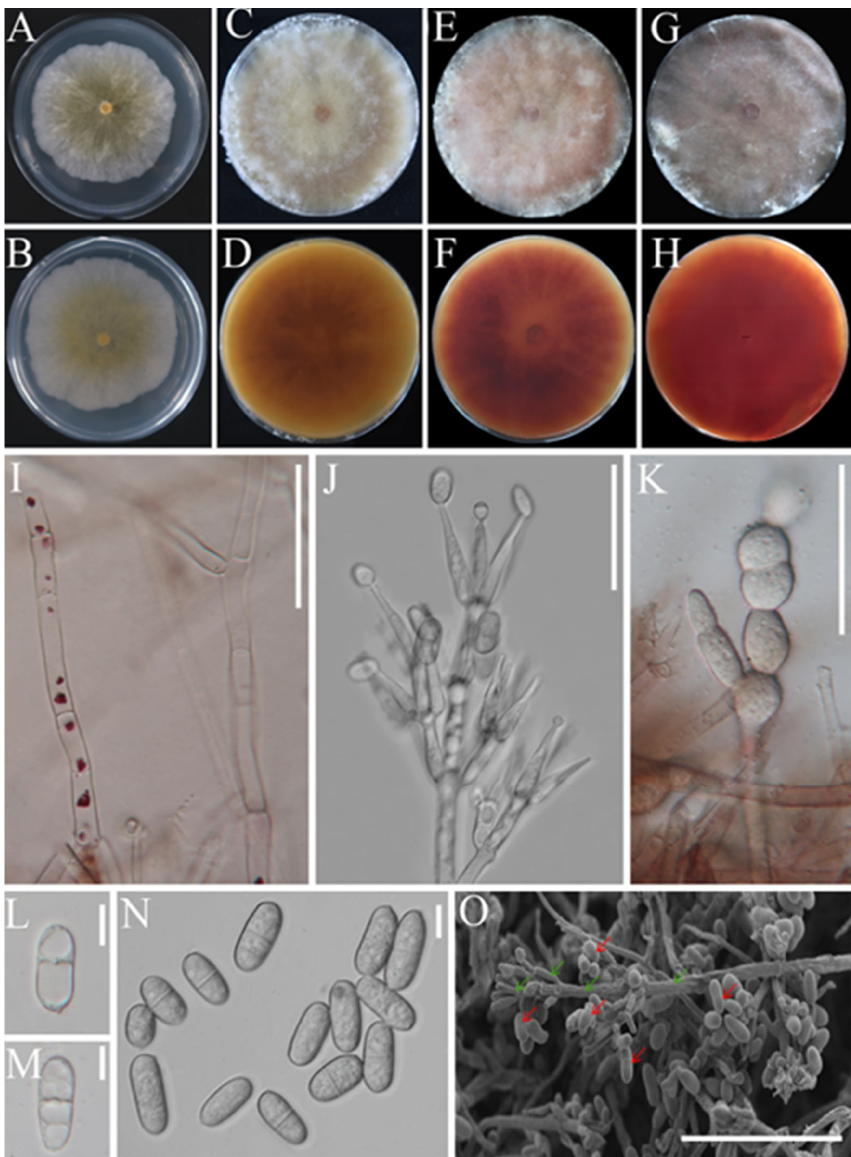
Figure 2. Colony and microscopic characteristics of C . mycophilum . ( A , B ): Depict the colony on PDA after 5 days and the reverse side, respectively; ( C , D ): depict the colony on PDA after 25 days and the reverse side, respectively; ( E , F ): depict the colony on PDA after 50 days and the reverse side, respectively; ( G , H ): depict the colony on PDA after 60 days and the reverse side, respectively. ( I , J ): Conidiophores, bar = 50 μ m; ( K ): chlamydospores, bar = 50 μ m; ( L – N ): conidiophores, bar = 10 μ m; ( O ): conidiophores (green arrow) and conidiophores (red arrow) under the scanning electron microscope, bar = 100 μ m.